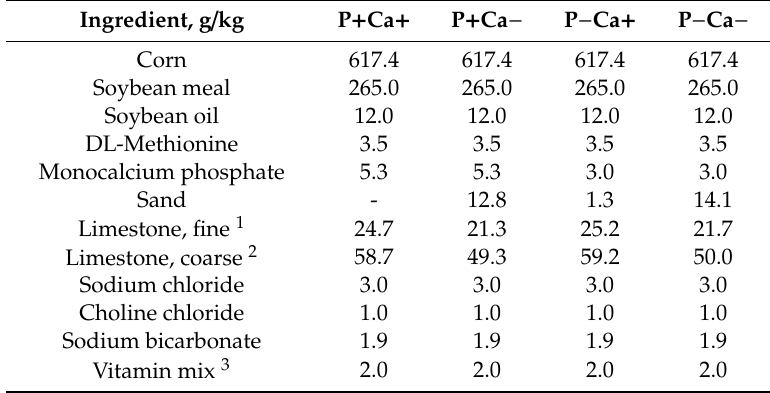
Ingredient composition and calculated and analyzed nutrient concentrations of the experimental